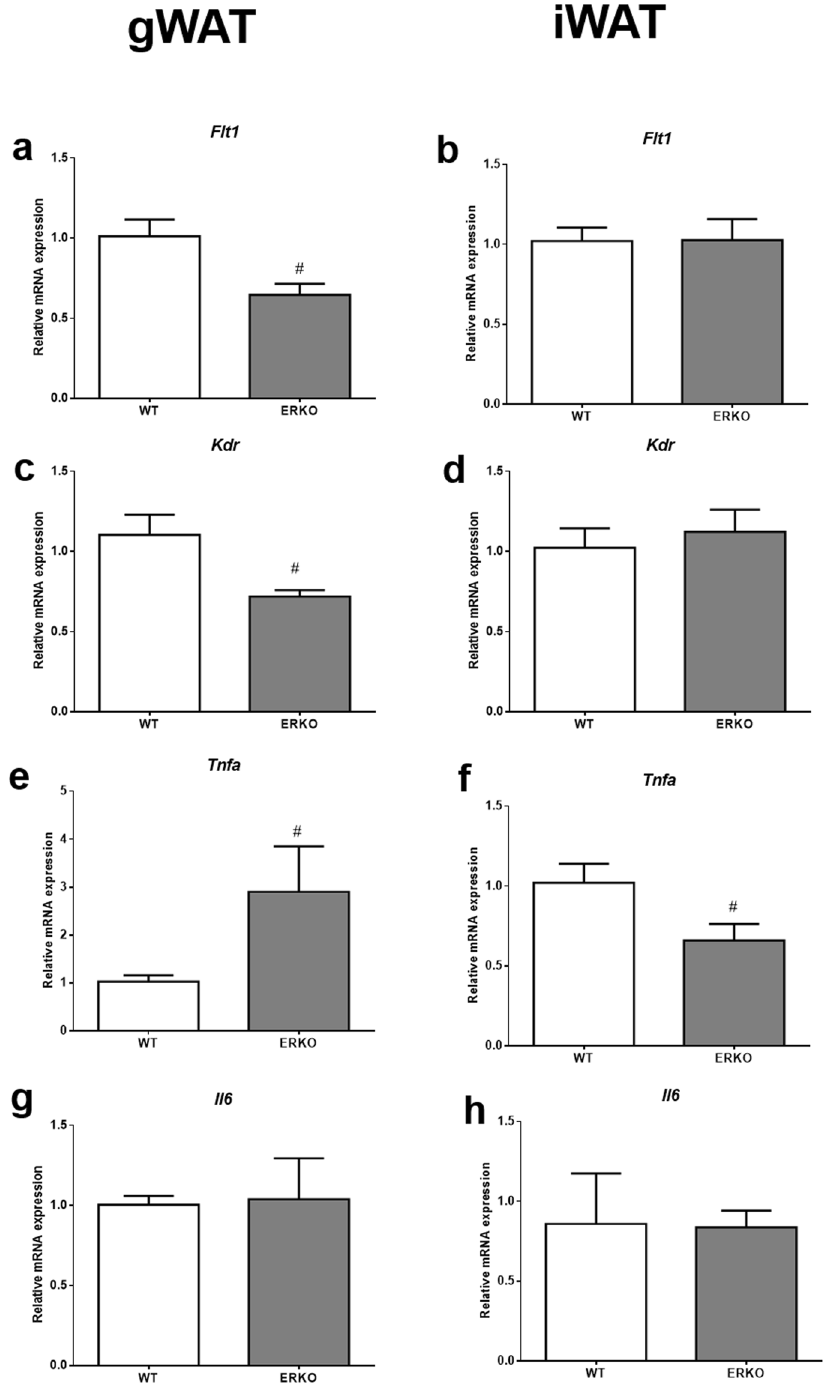
Figure 9. Relative mRNA expression of Vegf mRNA receptors, and inflammatory markers in iWAT and gWAT from WT and ERKO female mice. ( a and b ) Flt1 in gWAT and iWAT respectively; ( c and d ) Kdr in gWAT and iWAT respectively; ( e and f ) Tnfa in gWAT and iWAT respectively; ( g and h ) Il6 in gWAT and iWAT respectively. Data on the graphs are means ± SEM of 3–7 samples, # p < 0.05 vs